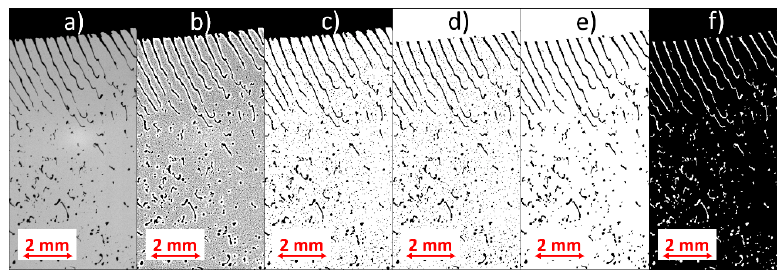
Figure 3. Image processing for the determination of pulsations by MATLAB: ( a ) raw image, ( b ) improvement of contrast, ( c ) binarization, ( d ) removal of bell edge, ( e ) suppression of noise, and ( f ) inversion.